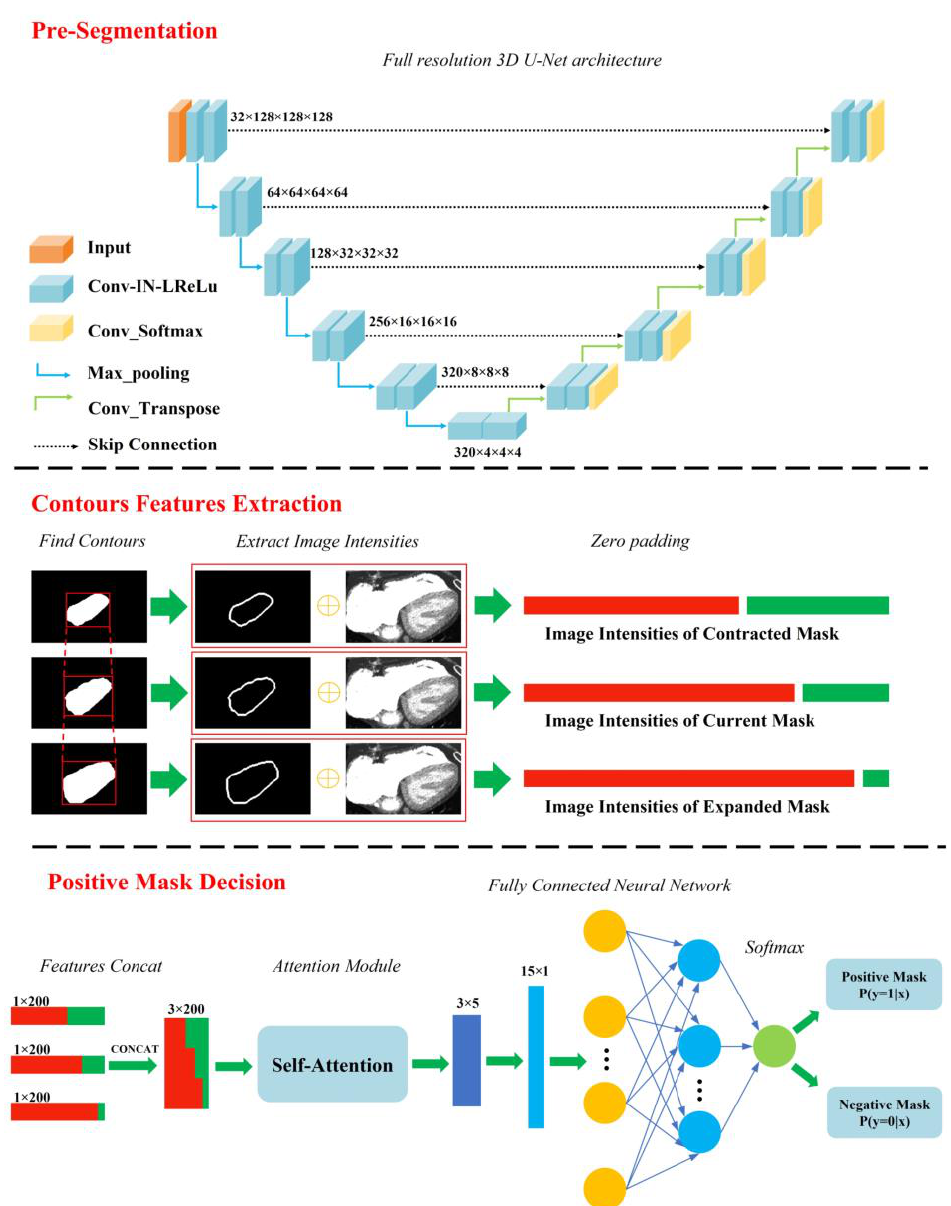
Figure 2. Segmentation framework architecture for accurate segmentation of the substructures of pulmonary artery and heart, respectively. The proposed segmentation framework consists of full-resolution 3D U-Net; contours feature extraction; and positive mask decision.